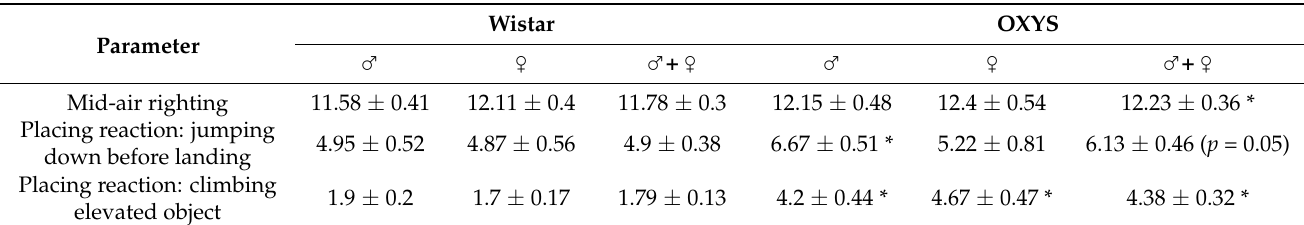
Table 4. The average day of formation of the mid-air righting reflex and placing